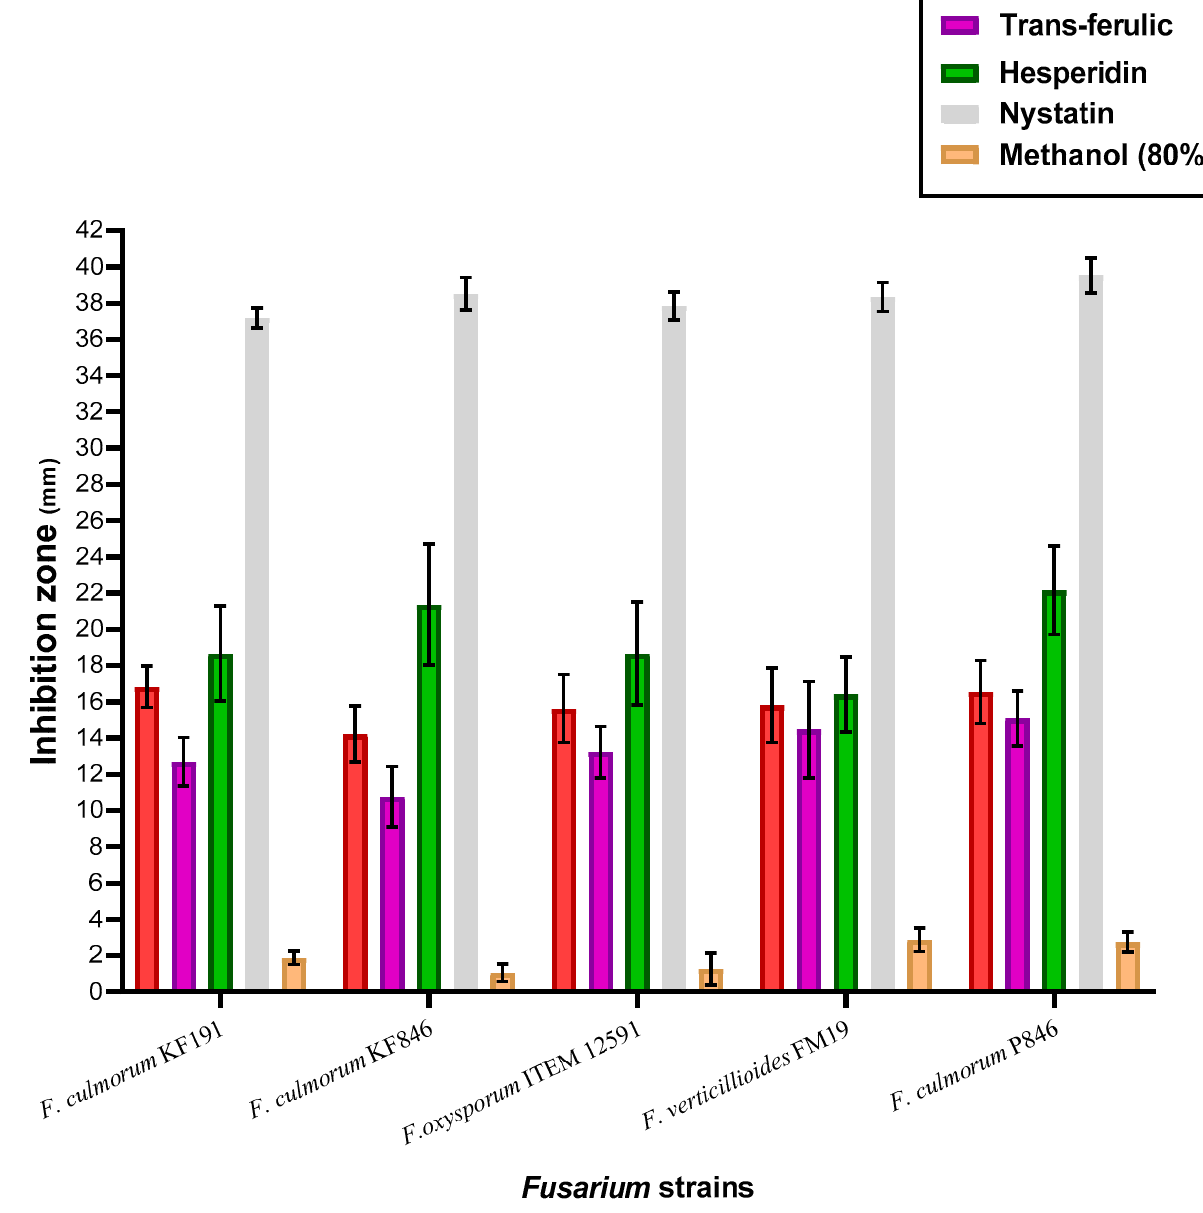
Figure 2. The anti-Fusarium activity of the crude extract, trans-ferulic, and hesperidin. Figure 2. The anti- Fusarium activity of the crude extract, trans-ferulic, and